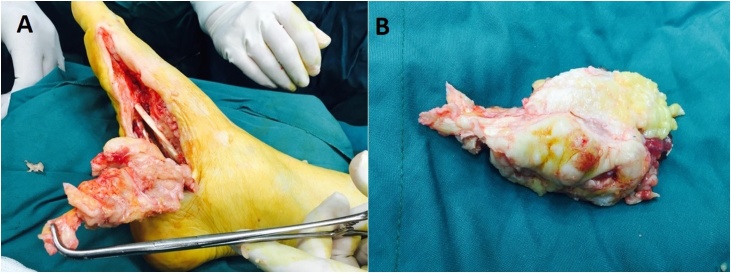
Intraoperative macroscopic appearance of subcutaneous soft tissue tumor indicates tumor was marginally resected and preserved the major neuro-vascular bundles, tendons and muscles (A, B).